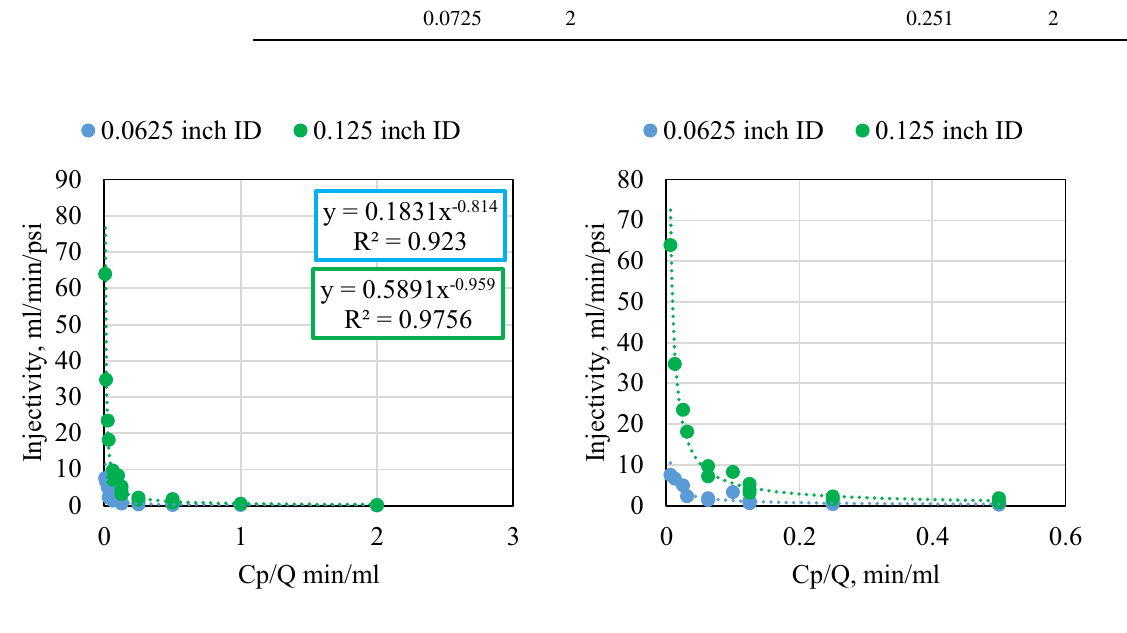
Fig. 4 Polymer injectivity as a function of polymer concentration and injection flowrate